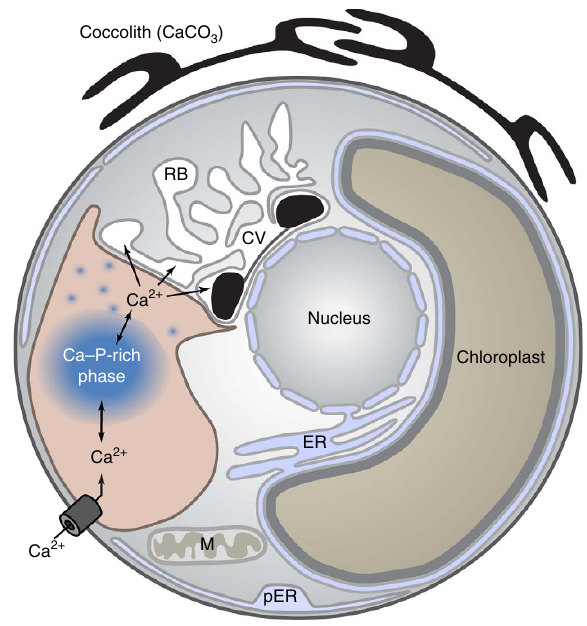
Figure 7 | Conceptual model of the coccolith calcium pathway. Ca accumulation and calcite precipitation are spatially and temporally separated. Calcium uptake into cells involves Ca transporter. The Ca ions are concentrated by polyphosphates into a disordered phase in a compartment distinct from the coccolith vesicle–reticular body system. The disordered Ca phase is a dynamic reservoir, concentrating and dispatching Ca ions. The released Ca ions are possibly transferred into the coccolith vesicle–reticular body system by Ca transporter and/or passive diffusion driven by a high-concentration gradient in free Ca ions. Inside the coccolith vesicle the calcium is precipitated as